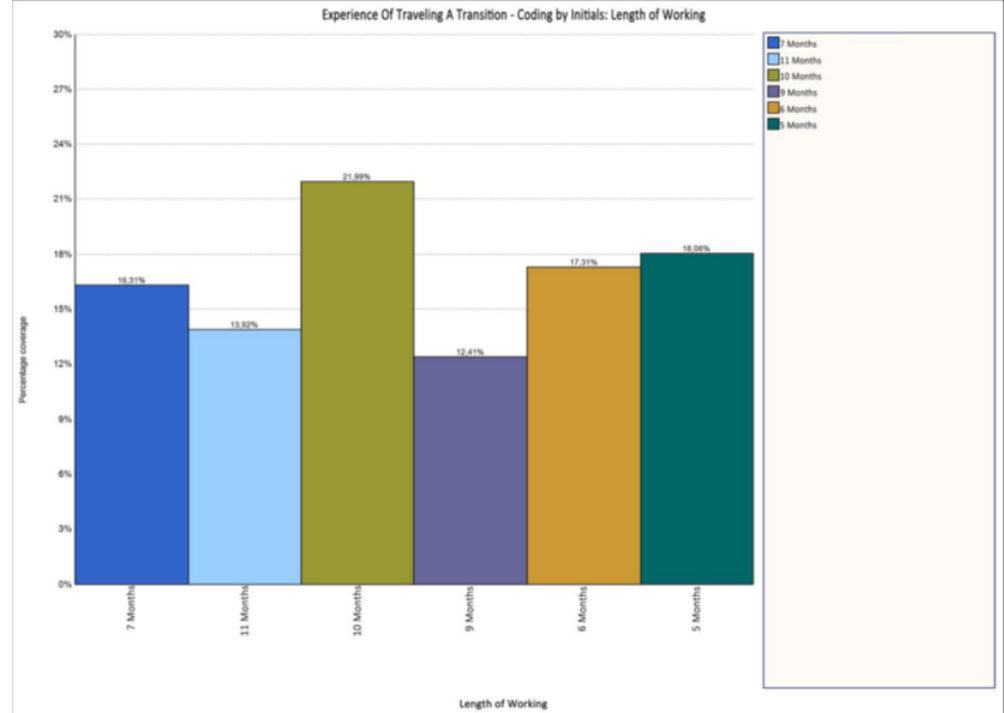
Fig. 14. Description of length of work affects transitional